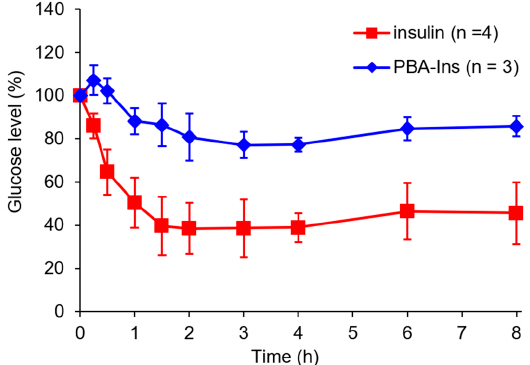
Figure 7. Profile of blood glucose level of subcutaneous injection of insulin or PBA-Ins (190 µg/kg). Each value presents as mean ± S.D. ( n = 4 or 3).